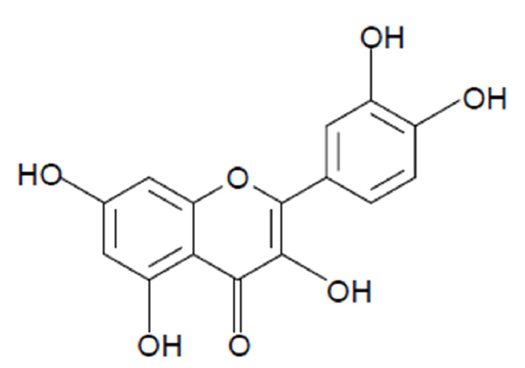
Figure 2. Structure of quercetin. Quercetin contains the basic structure of flavonoids: diphenylpro- pane (C6–C3–C6) with hydroxyl groups attached to the rings. The official nomenclature according to IUPAC is 2-(3,4-dihydroxyphenyl)-3,5,7-trihydroxy-4H-chromen-4-one. Other names include 5,7,3 ′ ,4 ′ -flavon-3-ol, sophoretin, meletin, quercetine, xanthaurine, quercetol, quercitin, quertine, and flavin meletin. Chemical formula: C 15 H 10 O 7 .